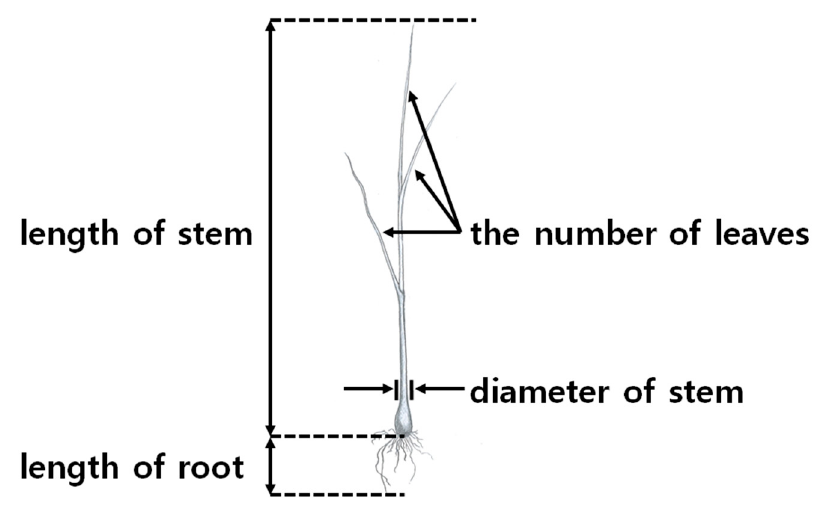
( h ) Figure 13. Growth status of onion seedlings:.( a ) Week 1; ( b ) Week 2; ( c ) Week 3; ( d ) Week 4; ( e ) Week 5; ( f ) Week 6; ( g ) Week 7; ( h ) Week 8. The growth status of 1344 onion seedlings was analyzed for both Group 1 and Group 2. Germination rate, number of leaves, diameter and length of stem, and length of root were used as